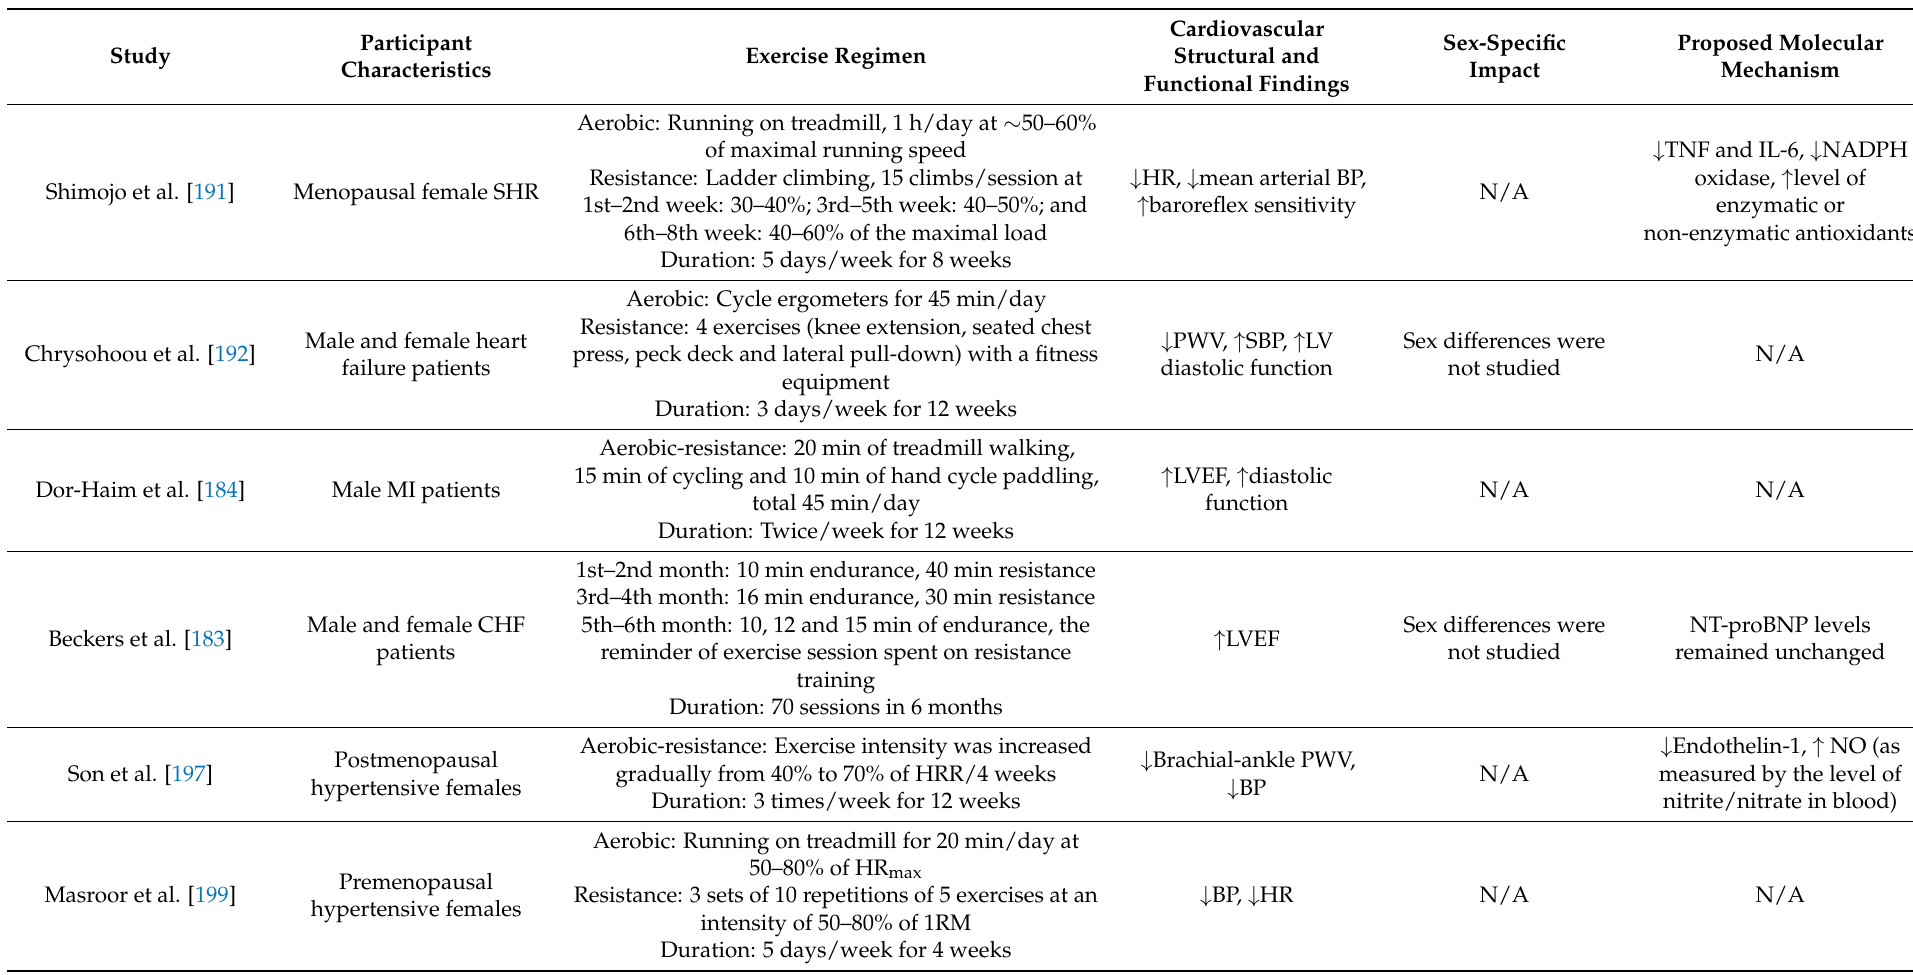
Table 5. The described studies associated with the combined exercise